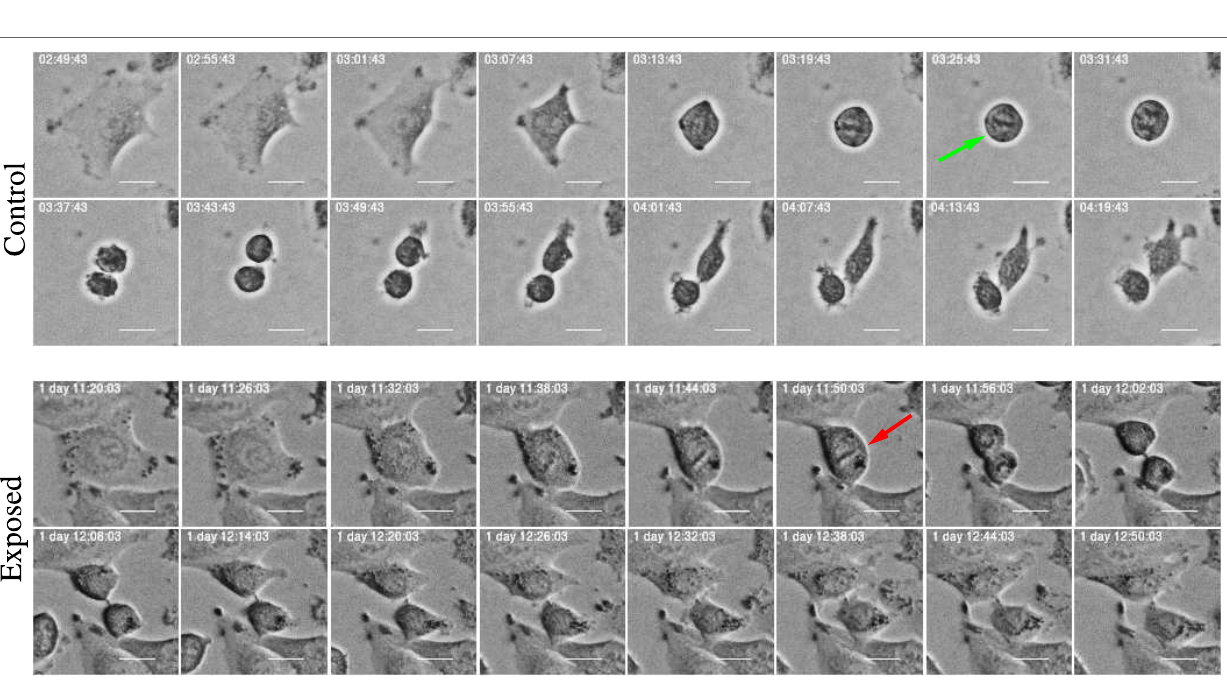
FigUre 15 | Time-lapse images of mitosis in control and exposed cells treated with YTX. Control cells exhibit normal mitotic rounding and the cells adopt a complete spherical form (green arrow) indispensable for timely mitotic progression. Exposed cells show failure in cell rounding (red arrow) which may induce defects in spindle assembly, pole splitting, and delay in mitotic progression. Scale bar: 20